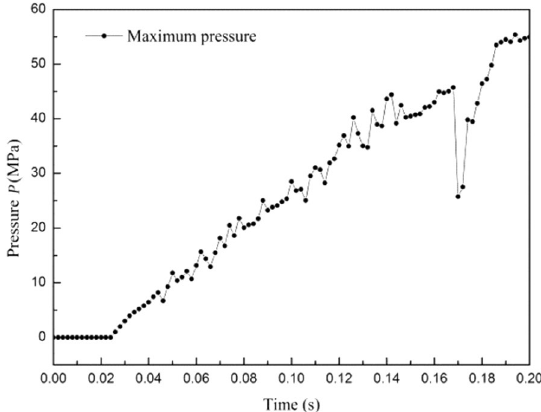
Figure 21 Time history curve of liquid pressure